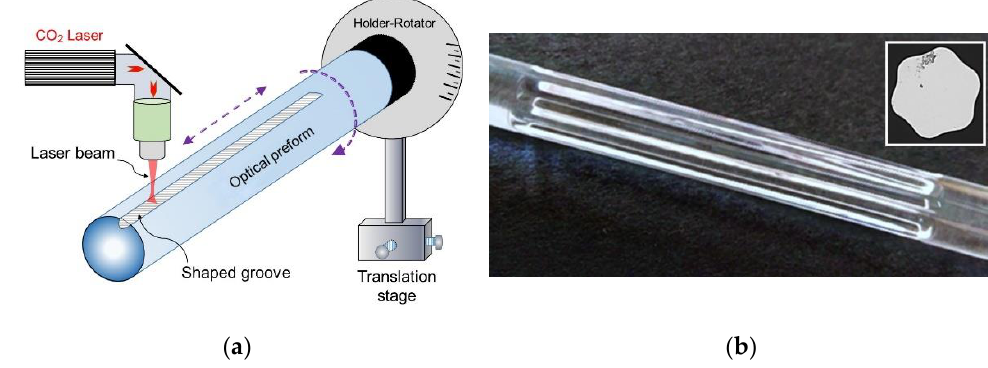
Figure 2. ( a ) Schematic diagram of the CO 2 laser shaping setup; ( b ) Longitudinal section of the thermally-shaped preform with hexagonal shape (inlet: cross section).